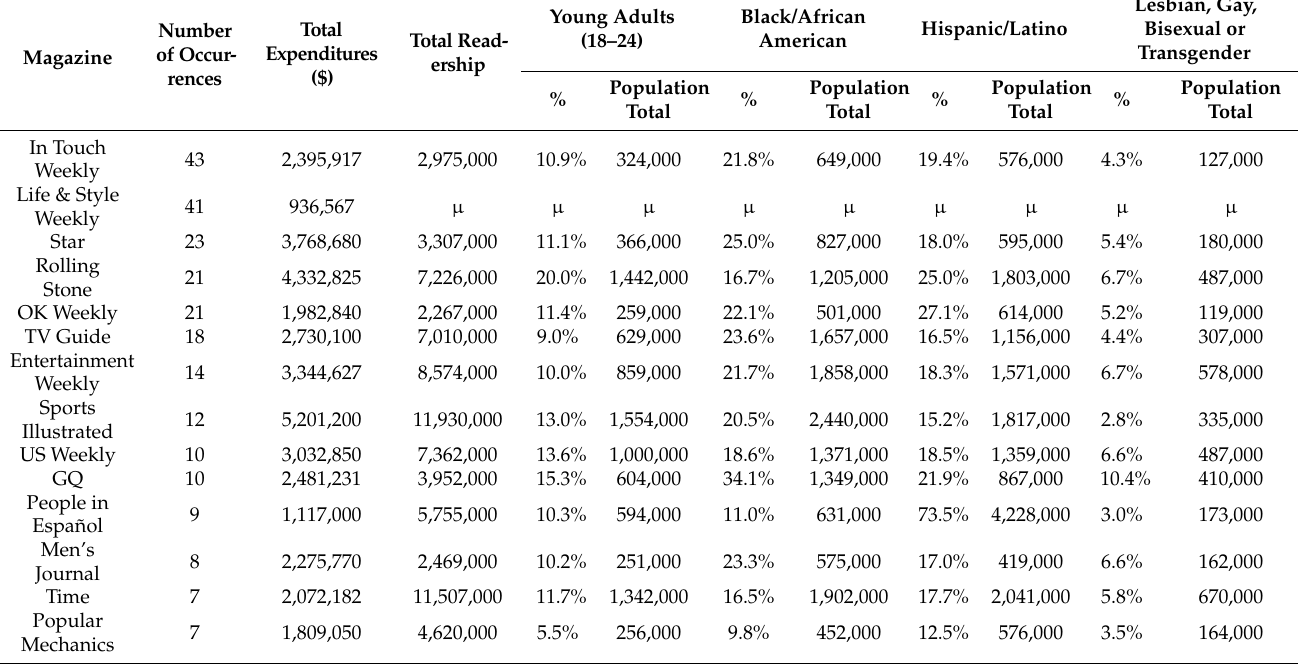
Table 2. Total Occurrences, Expenditures and Magazine Readership for Black & Mild Print